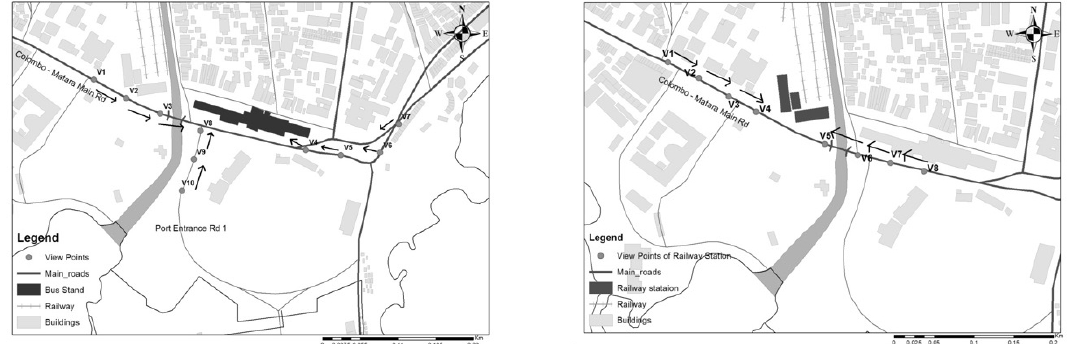
Figure 5. Viewpoints of the landmarks from H1 (Left: Galle bus stand; right: railway station)